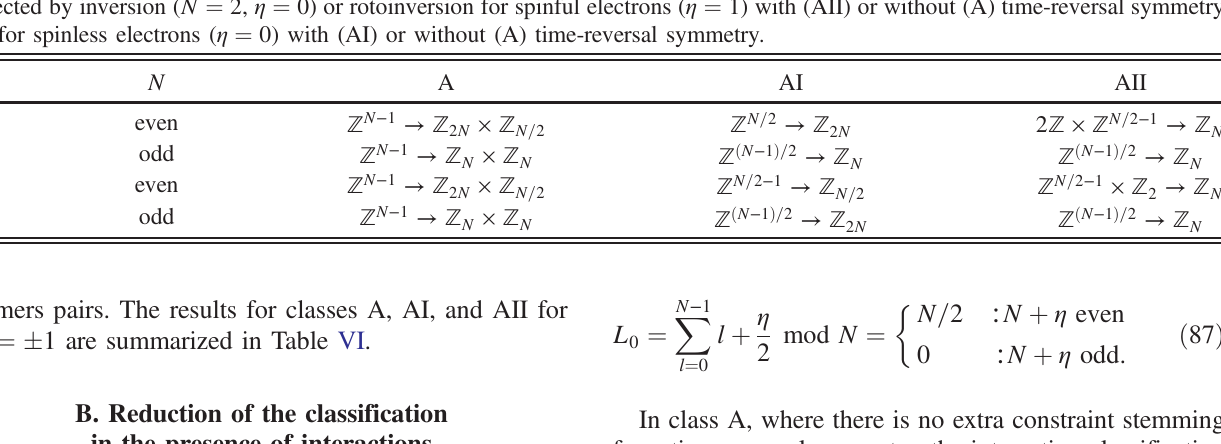
symmetry [ C N ¼ ð − 1 Þ η ¼ (cid:1) 1 ] under the adjoining N N